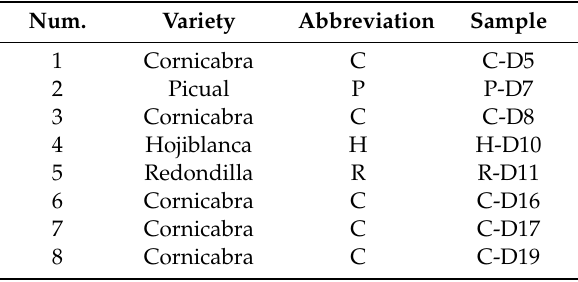
Table 2. Codification of the initial